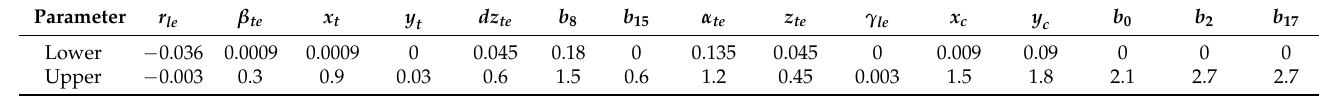
Table 4. Values of the upper and lower bounds of parameters used in the BP